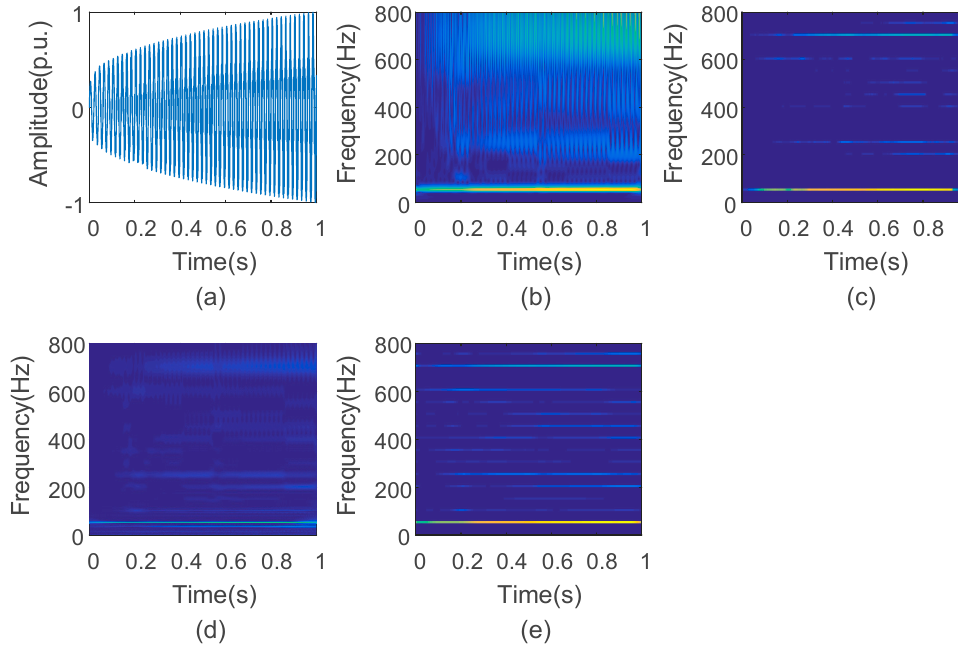
Figure 7. Wind power grid-connected model.